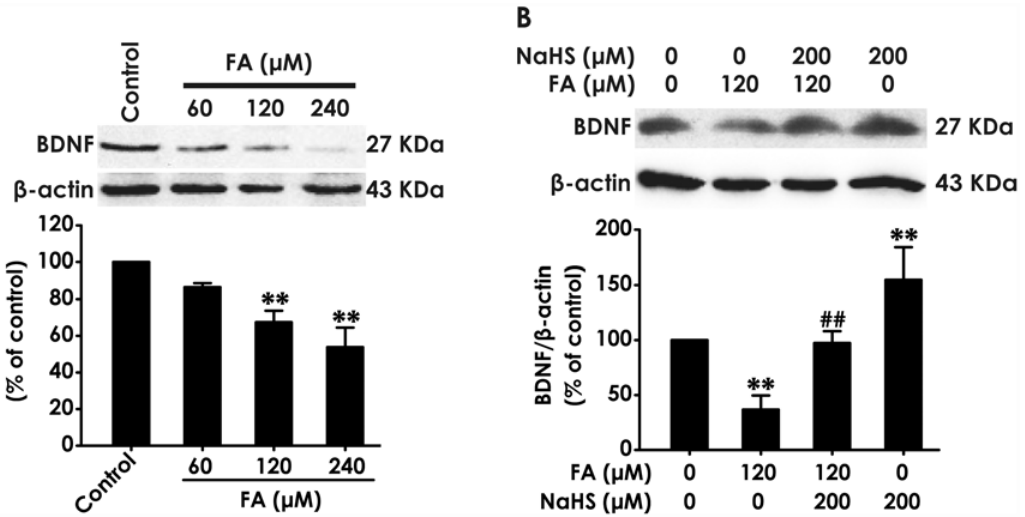
Fig 2. Effect of H 2 S on the expression of BDNF protein in formaldehyde-treated PC12 cells. (A) PC12 cells were treated with formaldehyde (FA, 60, 120, or 240 μ M) for 24 h. (B)After pretreatment of PC12 cells with NaHS (200 μ M) for 30 min, FA (120 μ M) was added to culture medium and coincubated for 24 h. The expression of BDNF protein was determined by Western blot using anti-BDNF antibody, and β -actin was used as a loading control. The ratio of BDNF to β -actin is normalized by the value in control group. Values were expressed as the mean ± S.E.M. of three independent experiments. ** P < 0.01, versus control group; ## P < 0.01, versus FA-treated along group.